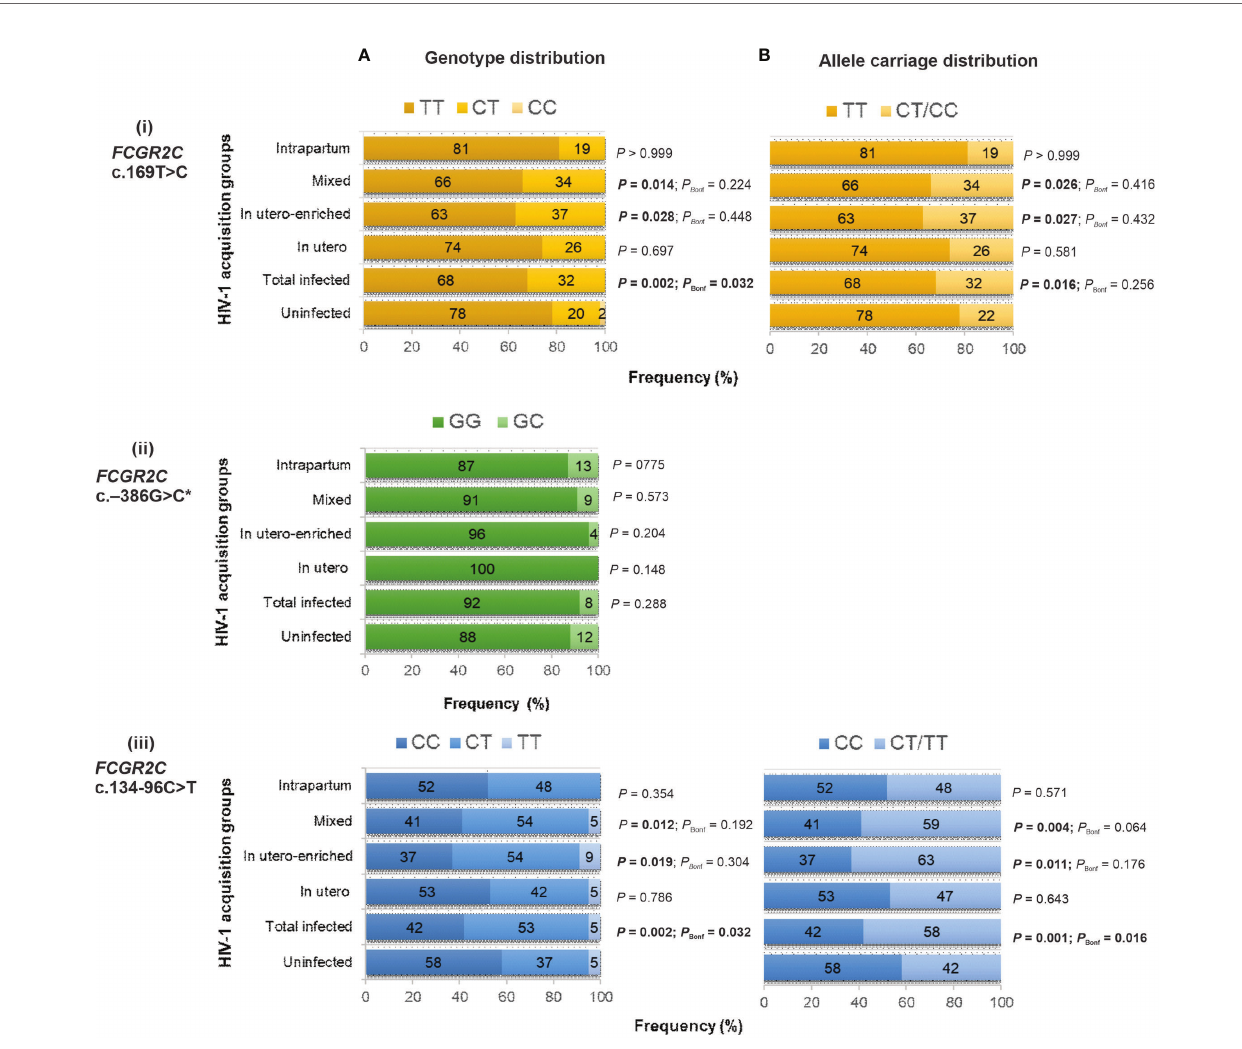
FIGURE 2 | Genotype (A) and allele carriage (B) distribution of functional FCGR2C variants and their association with perinatal HIV-1 acquisition in black South Africans [HIV-1-exposed uninfected (n = 349), total infected (n = 176 for c.134-96C>T; n = 166 for c.169T>C and c. − 386G>C), in utero infected (n = 19), in utero - enriched infected (n = 46), mixed infected (n = 99 for c.134-96C>T; n = 89 for c.169T>C and c. − 386G>C) and intrapartum infected (n = 31)]. * No individual with homozygous − 386 CC